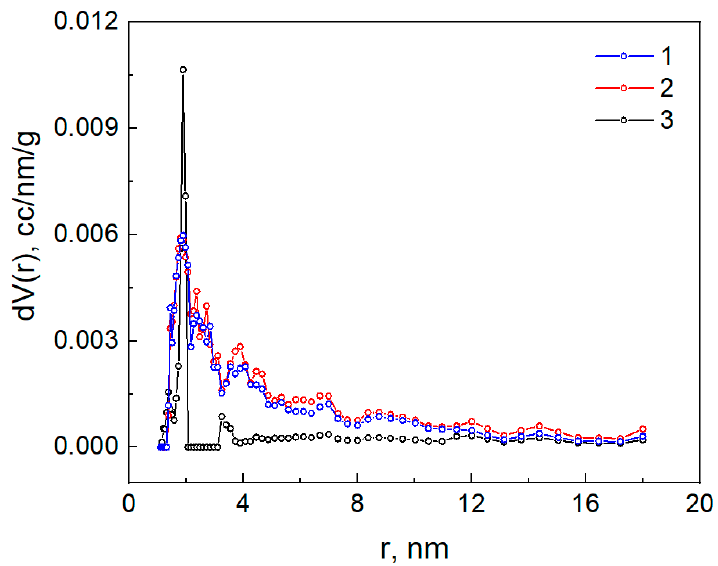
Figure 10. Distribution of pores in synthesized nanocomposites according to DFT model, 1—NC1_10; 2—NC1_5; 3—NC2.